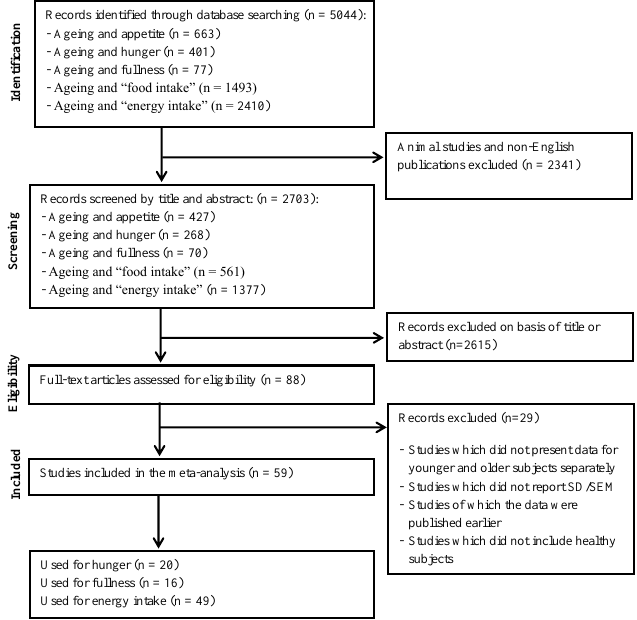
Figure 1. Flow diagram for the selection of